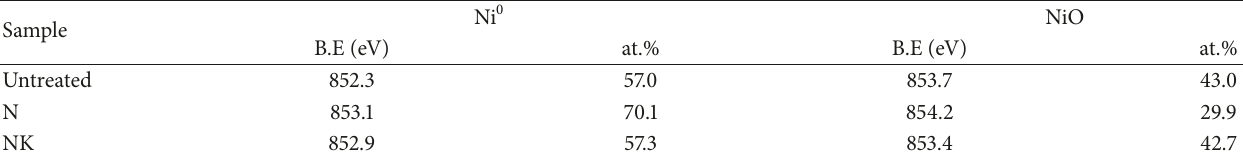
Figure 4: XPS spectra for the Ni2p 3/2 core levels: (a) N; (b) NK; and (c) untreated samples. Table 5: XPS fitting results for the Ni2p 3/2 core